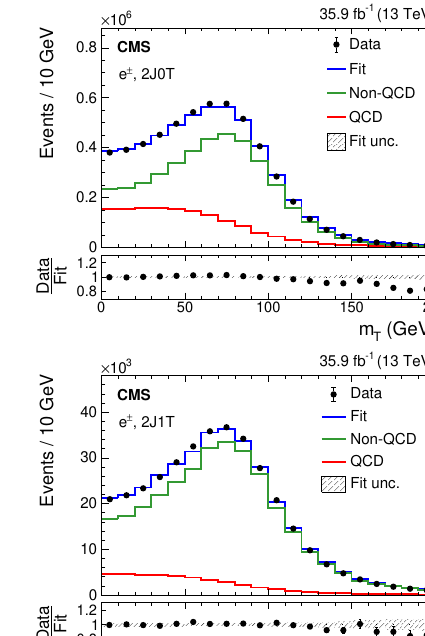
Figure 3 . Projections of the fit results onto the m (right) final states in the 2J0T (upper) and 2J1T (lower) categories for the data (points) and the various components of the fit (colored lines). The lower panels show the ratio of the data to the fit predictions. The bands represent the uncertainty in the m